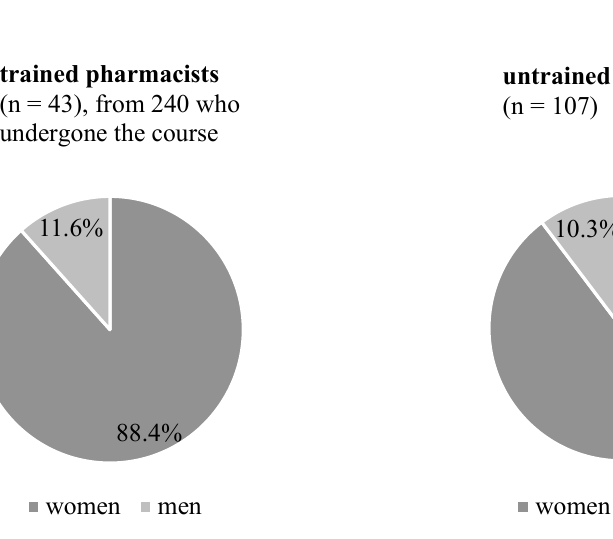
Figure 1. Pharmacists included in the study.